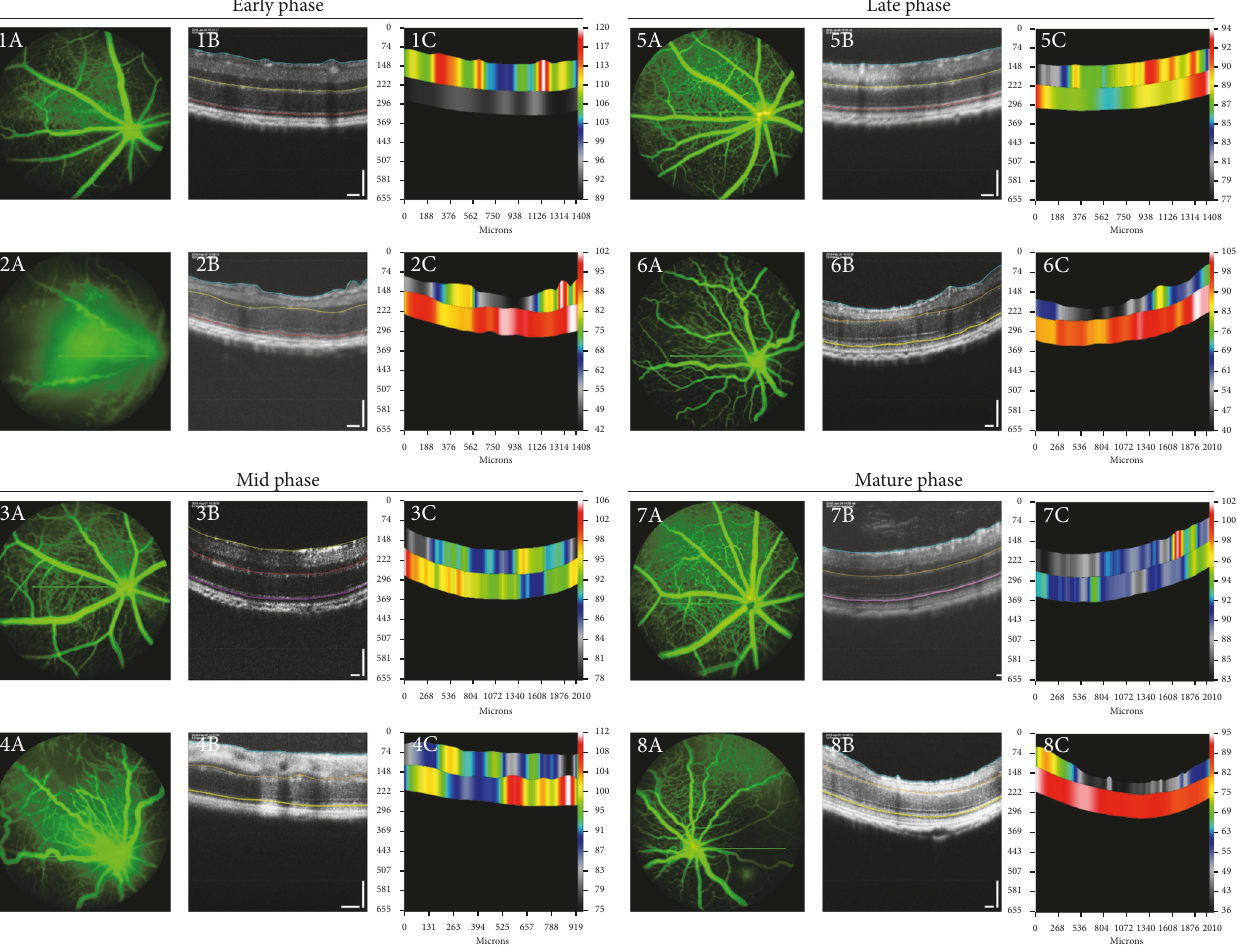
Figure 3: FA and SD-OCT at early, mid, late, and mature phases of retinal vascular development. (1A – C) represents P19 RA mice (early phase RVD); (2A – C) represents P19 OIR mice (early phase RVD); (3A – C) represents P24 RA mice (mid phase RVD); (4A – C) represents P24 OIR mice (mid phase RVD); (5A – C) represents P32 RA mice (late phase RVD); (6A – C) represents P32 OIR mice (late phase RVD); (7A – C) represents P47 RA mice (mature phase RVD); and (8A – C) represents P47 OIR mice (mature phase RVD). Note: SD-OCT refers to spectral domain optical coherence tomography; RVD refers to retinal vascular development. Numbering: 1 refers to P19, 2 refers to P24, 3 refers to P32, and 4 refers to P47. Lettering: A refers to FA image, B refers to SD-OCT image, and C refers to thickness color